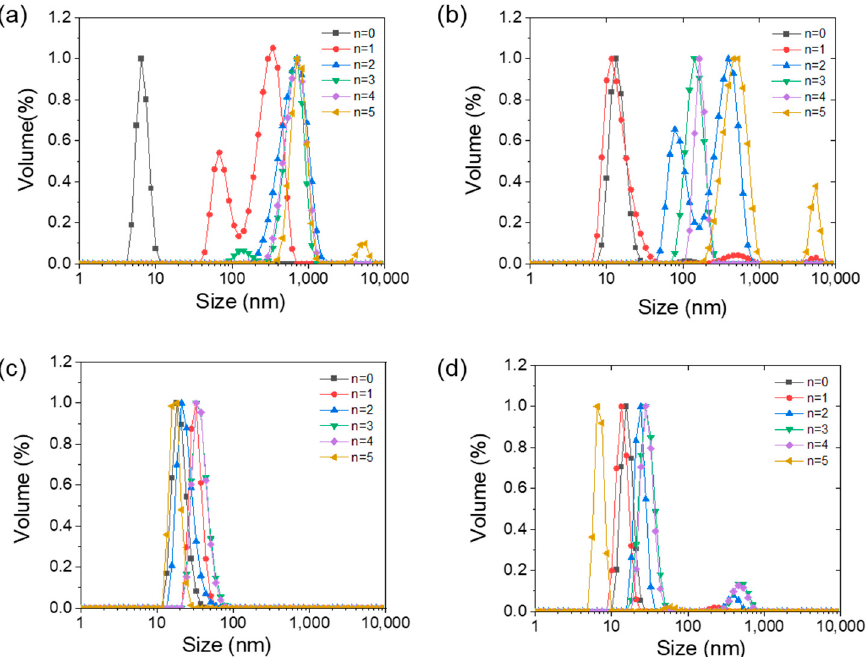
Figure 4. Particle size of α -amylase ( a ) and α -amylase/ λ -carrageenan mixtures with a ratio of 100:1 ( b ), 10:1 ( c ), and 1:1 ( d ) after PEF treatment, n represents the number of cycles.